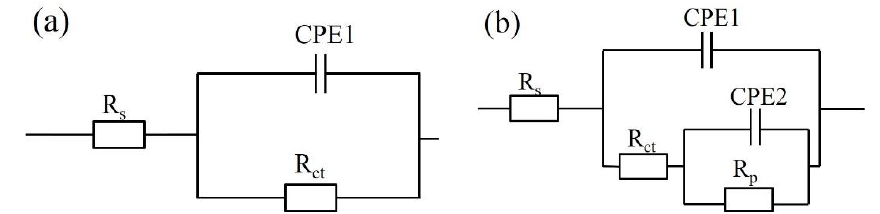
Figure 5. Equivalent electrical circuit model used to fit the EIS data; ( a ) is used for Zr-30 at.% Cu, 50 at.% Cu and 90 at.% Cu; ( b ) is used for Zr-80 at.% Cu, R ct -charge transfer resistance of oxide layer, R p -resistance of electrochemical reaction at electrolyze/glassy coating interface.